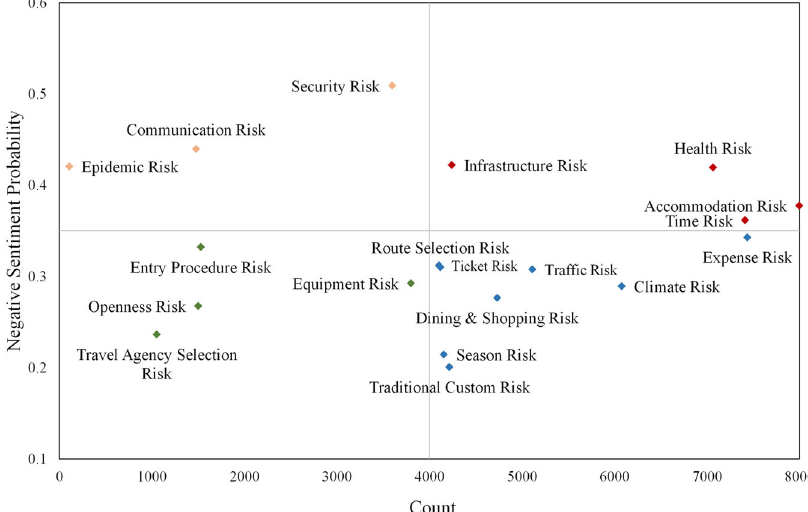
Fig. 7 Four-quadrant diagram of post-travel perceived risks. Comparison of risk perception frequency and negative sentiment probabilities after travel.